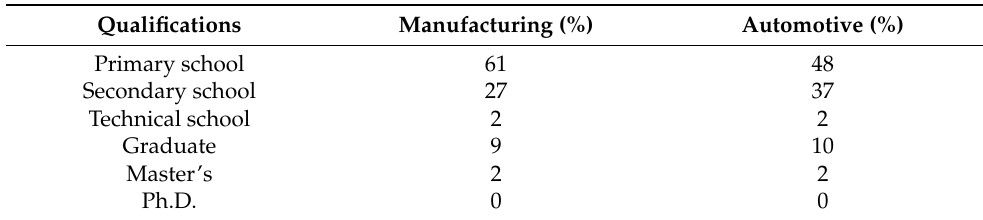
Table 4. Distribution of formal qualification in the automotive and manufacturing sectors in Portugal in 2019.